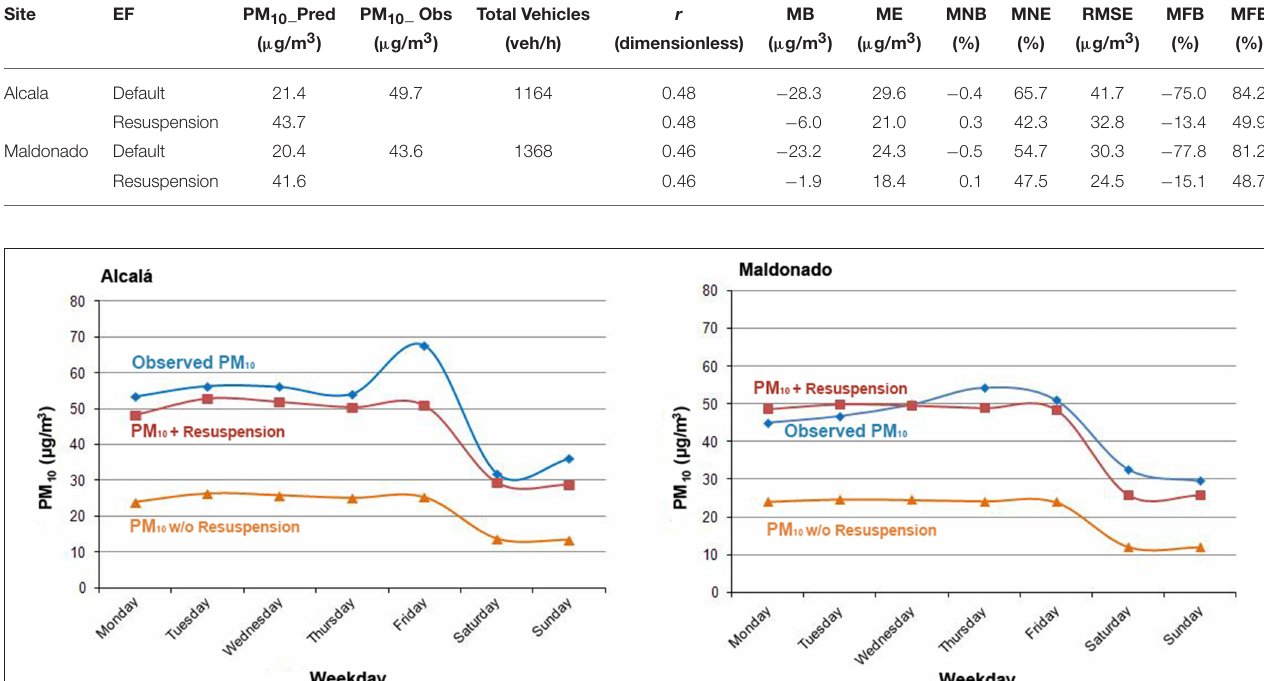
FIGURE 3 | Daily average PM 10 comparison for OSPM simulations in Alcalá and Maldonado sites.